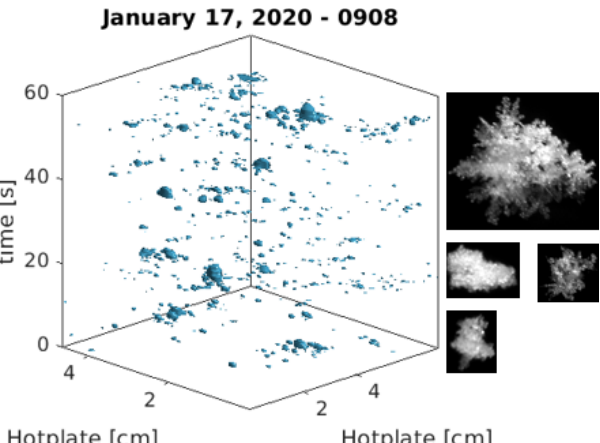
Figure B5. As for Fig. B1 but for a mixture of densely rimed and aggregate